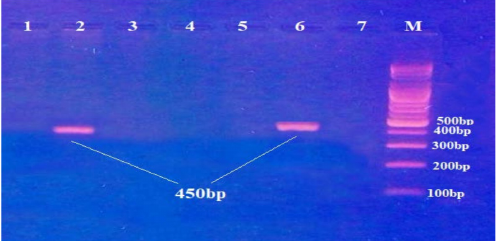
Fig. 1. Gel electrophoresis of nested- PCR products of Human Papillomavirus L1 capsid gene (the first round) stained with ethidium bromide and visualized under ultra-violate. M: DNA marker, Lanes 2 and 6: positive results for amplification (450bp). Lanes 1,3,4,5 and 7: negative results.